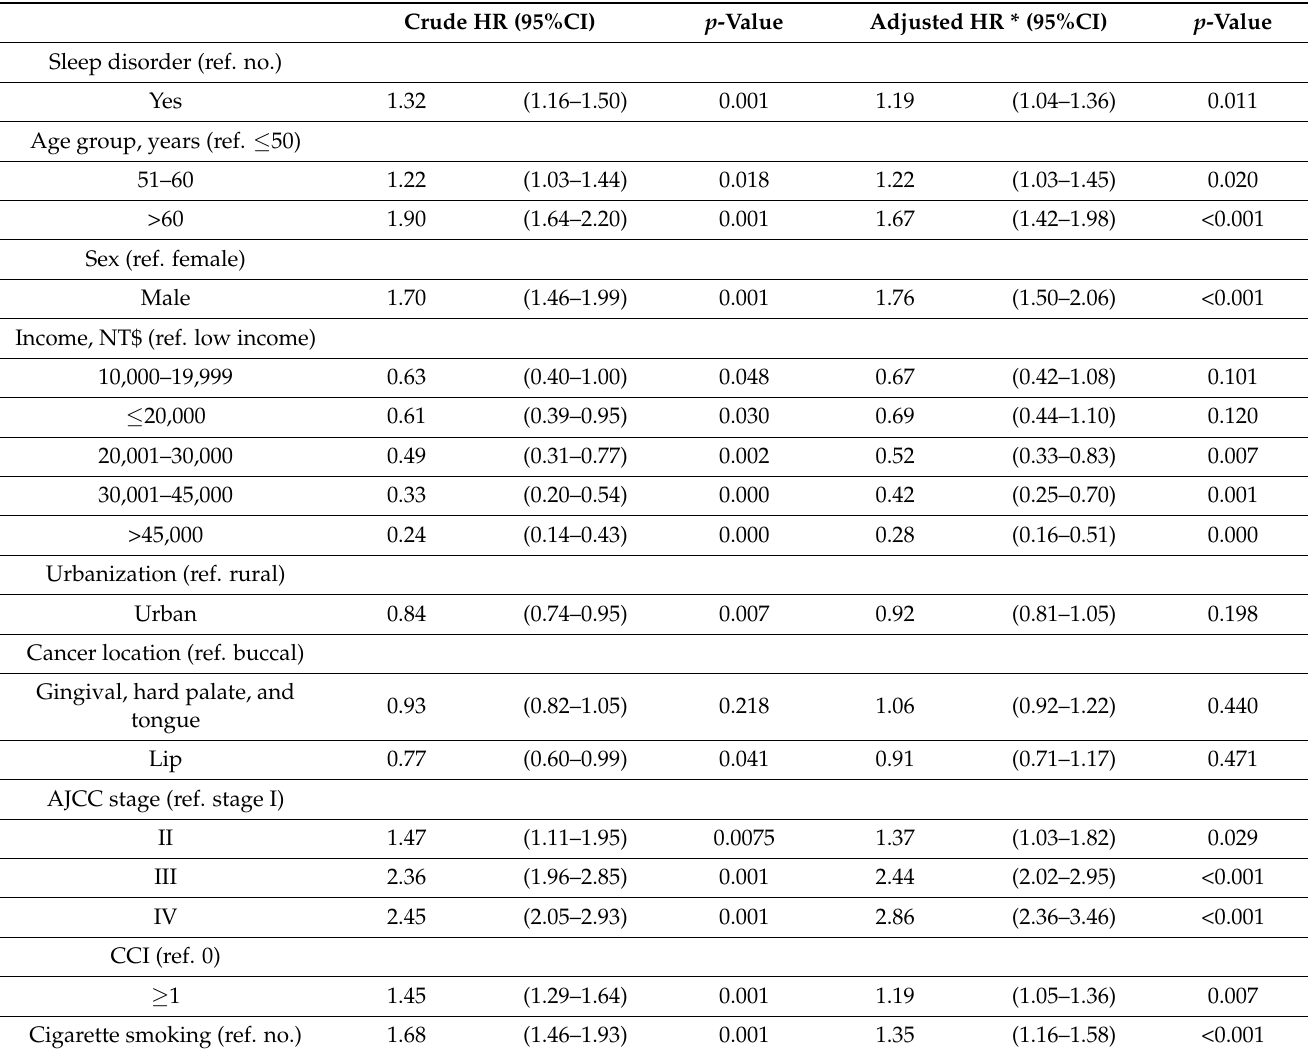
Table 2. Univariable and multivariable Cox proportional regression of all-cause mortality between patients with oral cavity squamous cell carcinoma with and without sleep disorders. Crude HR (95%CI) p -Value Adjusted HR * (95%CI) p